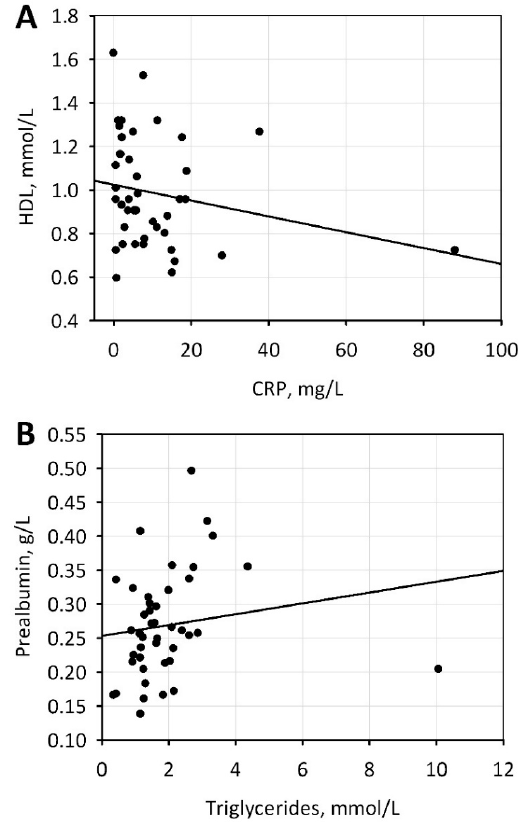
Figure 2. Correlations between lipid markers and selected markers of malnutrition and inflammation: HDL-cholesterol and CRP ( A ), triglycerides and prealbumin ( B ). HDL: high-density lipoprotein; CRP: C-reactive protein.